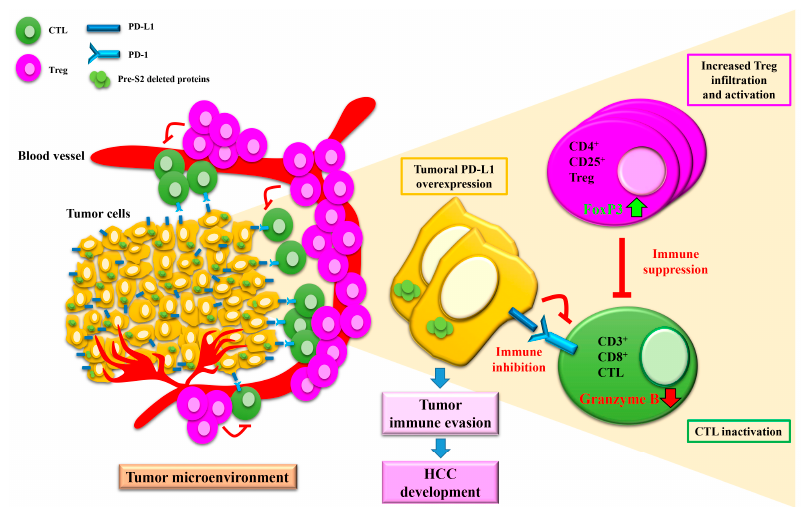
Figure 5. Schematic representation of the hypothetical model of HBV pre-S2 deleted proteins in the regulation of the tumor immune microenvironment in HCC. In the tumor microenvironment of HCC patients positive for pre-S2 deleted proteins, the expression of PD-L1 in tumor cells is elevated, the infiltration and activity of CD4 + CD25 + Tregs are increased (as shown by increased cell number and forkhead box P3 (Foxp3) expression), and the activity of CD3 + CD8 + CTLs is decreased (as shown by decreased granzyme B expression and secretion). Tregs have been shown to exert “pro-tumor” activity by suppressing the activity of “anti-tumor” CTLs [57]. In addition, PD-L1 expressed in tumor cells has been shown to interact with its receptor, PD-1, expressed in CTLs, to dampen the attack of tumor cells by CTLs [58]. The combined effects of tumoral PD-L1 overexpression, increased Treg infiltration and activation, and CTL inactivation favor tumor cell evasion from host immune surveillance, contributing to HCC development in patients with pre-S2 deleted proteins. Abbreviations: Treg, regulatory T cell; Foxp3, forkhead box P3; CTL, cytotoxic T cell; PD-L1, programmed death ligand 1; PD-1, programmed death 1; HCC, hepatocellular